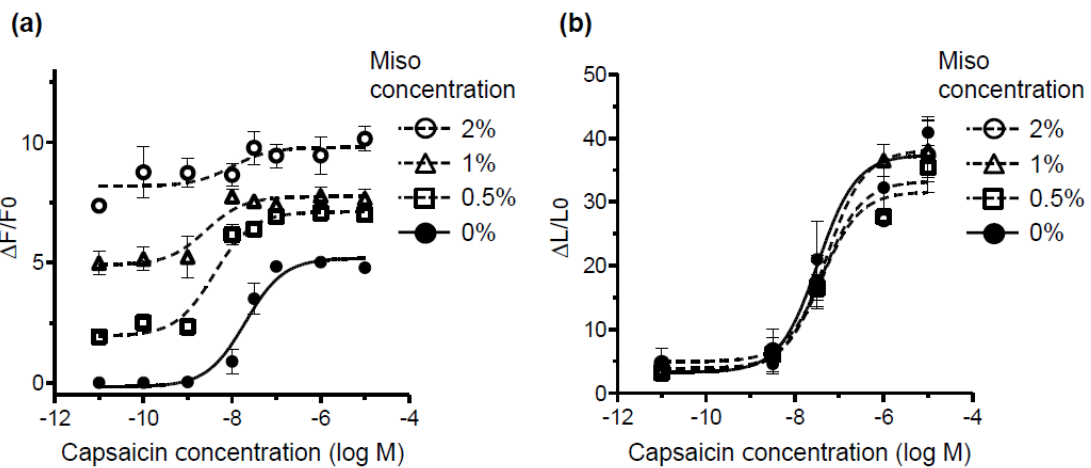
Figure 4. Evaluation of hTRPV1 activity induced by capsaicin using the fluorescence- and luminescence-based assay systems in the presence of miso, which contains fluorescent substances. Dose–response curves for capsaicin on hTRPV1 obtained in the fluorescence ( a ) and luminescence ( b ) assays in the absence and presence of 0.5, 1, and 2% of miso. Data are presented as the average ( n = 3) ± SE (error bars).